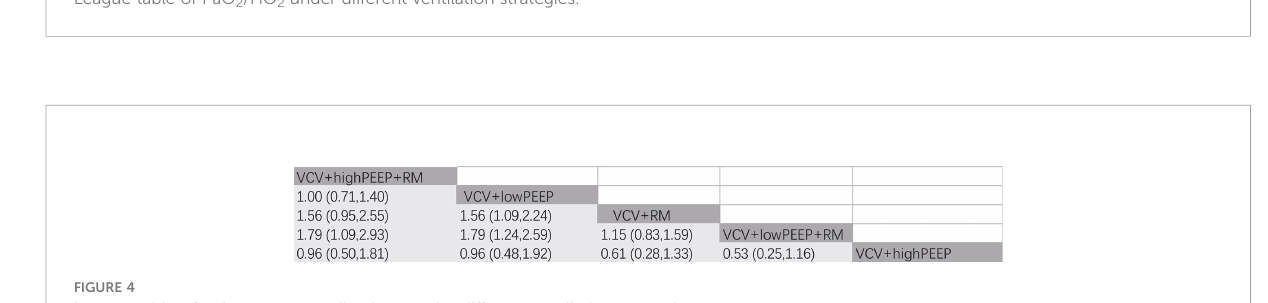
FIGURE 3 League table of PaO 2 /FiO 2 under different ventilation strategies.